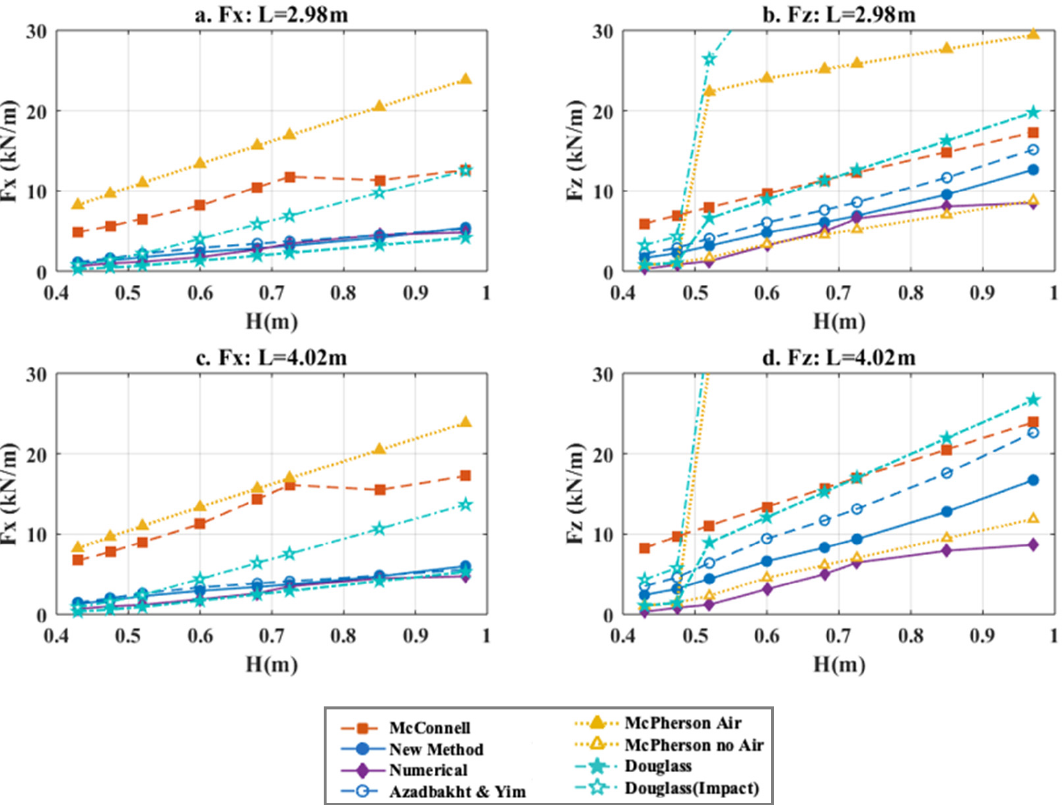
Figure 24. Comparisons of the maximum wave forces predicted by different methods with the numerical results, for two decks with different widths (150% L and 200% L ).